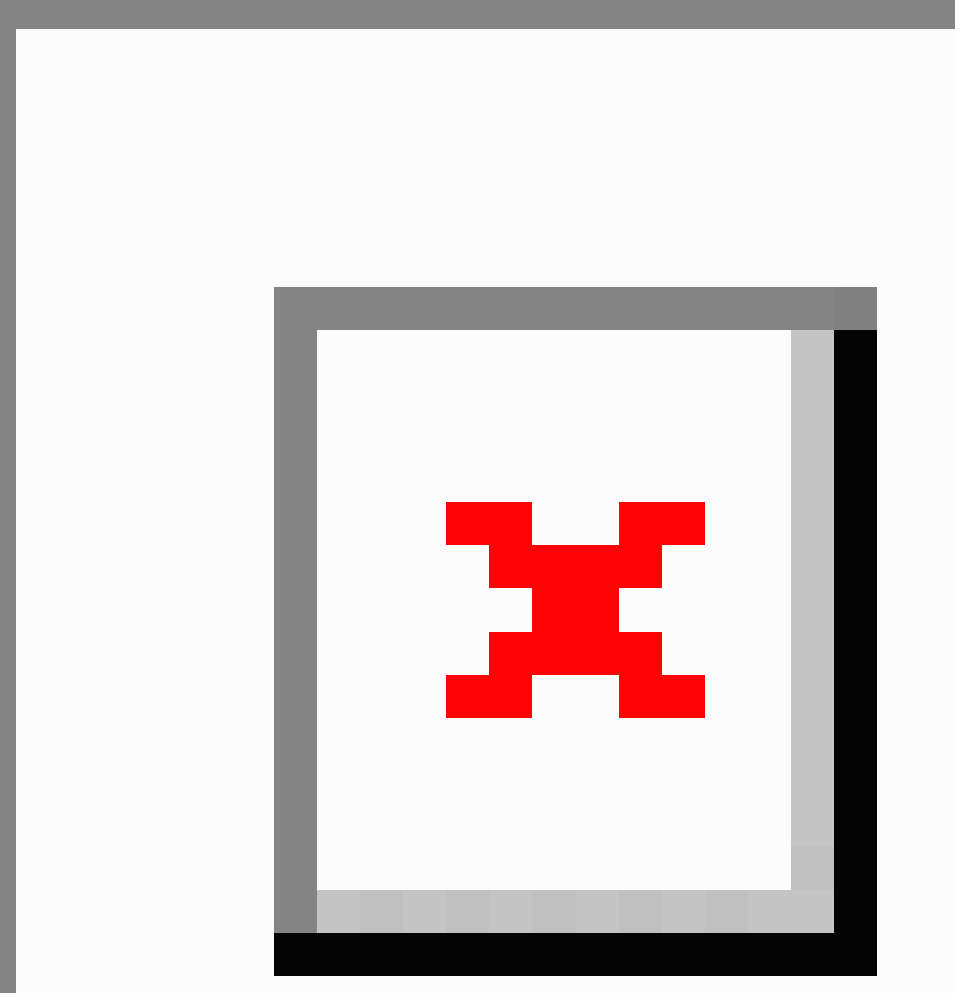
Figure 1. Illicit Internet-based direct-to-consumer advertising (eDTCA) ad created for